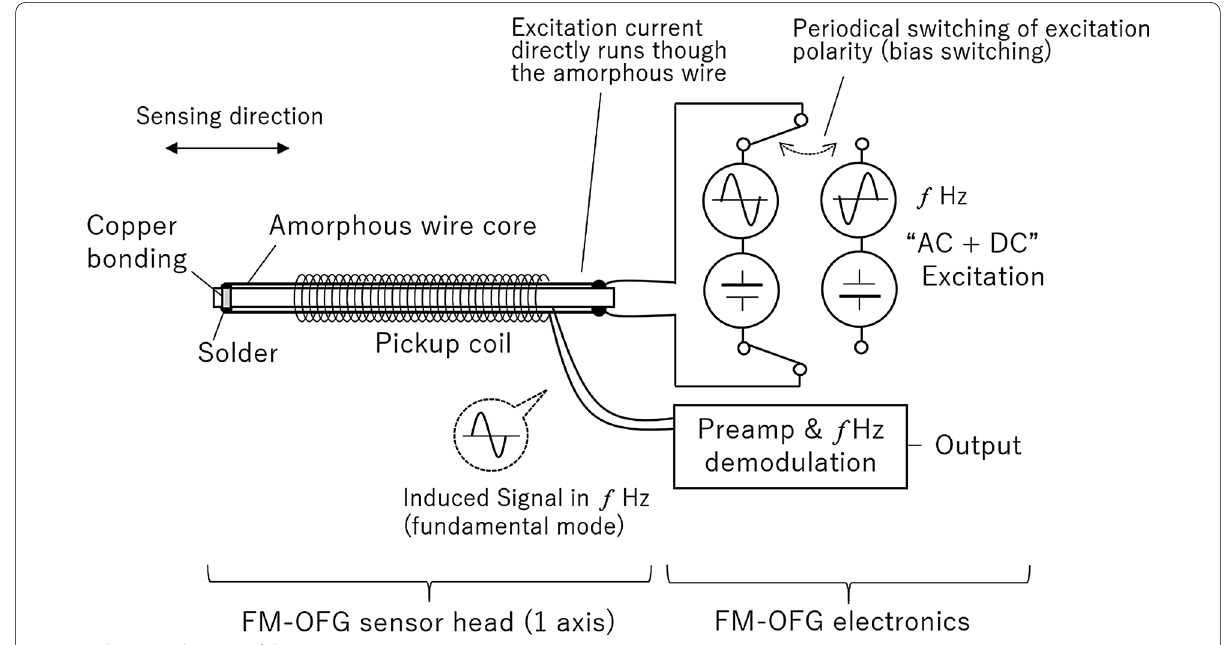
Fig. 4 Schematic diagram of the MSA magnetometer